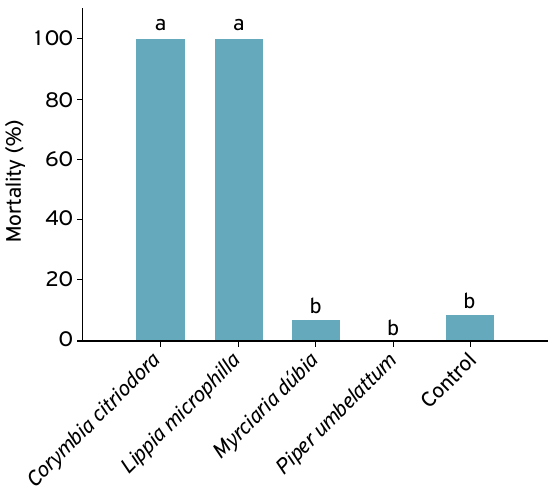
Figure 1. Mortality (%) of Spodoptera frugiperda 10 days after the topical application of four essential oils at 30 mg.g -1 dosage. Averages followed by the same letters do not differ by the Dunn’s test at 5% probability.